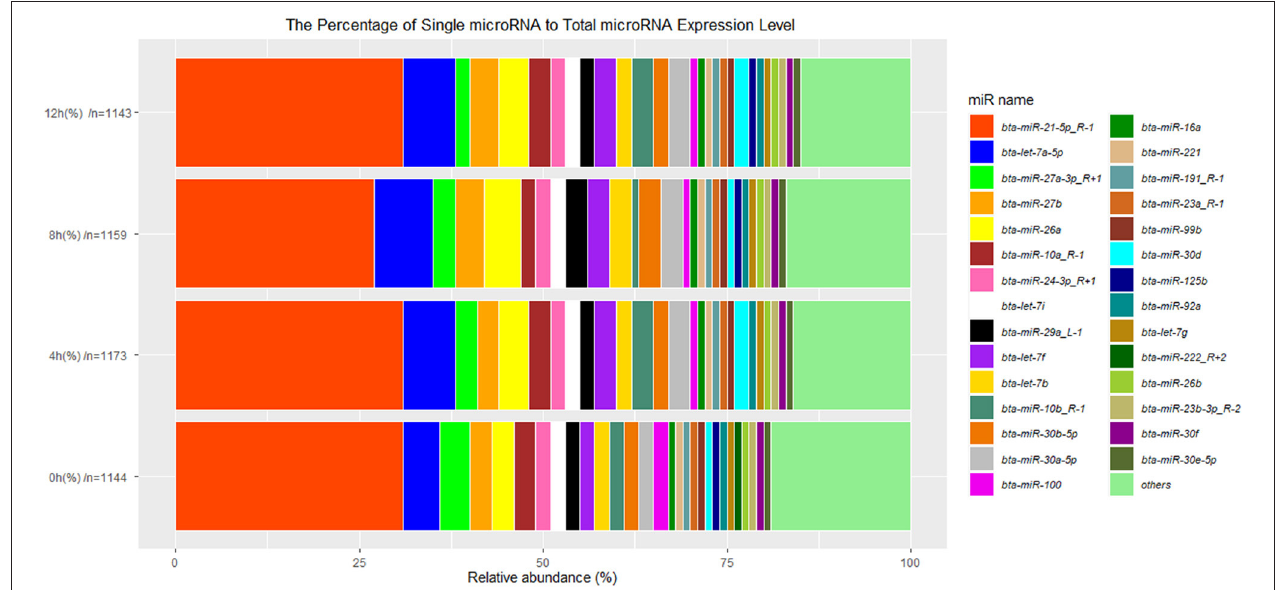
FIGURE 4 | The 29 top-expressed miRNAs at 0, 4, 8, and 12h LPS-induced bMECs. “ n ” represents the number of identified miRNAs at 0, 4, 8, and 12h LPS induced